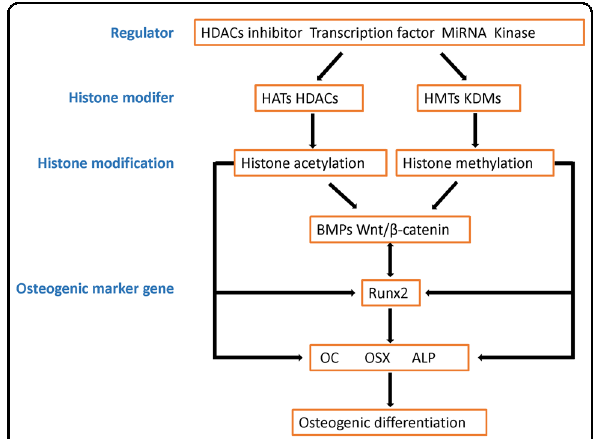
Fig. 1 Schematic model of the roles of histone modi fi cation in osteogenic marker genes expression. During osteogenic differentiation, numbers of regulators are found to modulate histone acetylation and methylation by affecting the catalytic activity of histone modi fi ers. The altered histone acetylation and methylation then control expression of osteogenic marker genes, directly or indirectly. HATs histone acetyltransferases, HDACs histone deacetylases, HMTs histone methyltransferases, KDMs histone demethylases, BMPs bone morphogenetic proteins, HOXs homeobox genes, Runx2 runt-related transcription factor 2, OC osteocalcin, OSX osterix, ALP alkaline